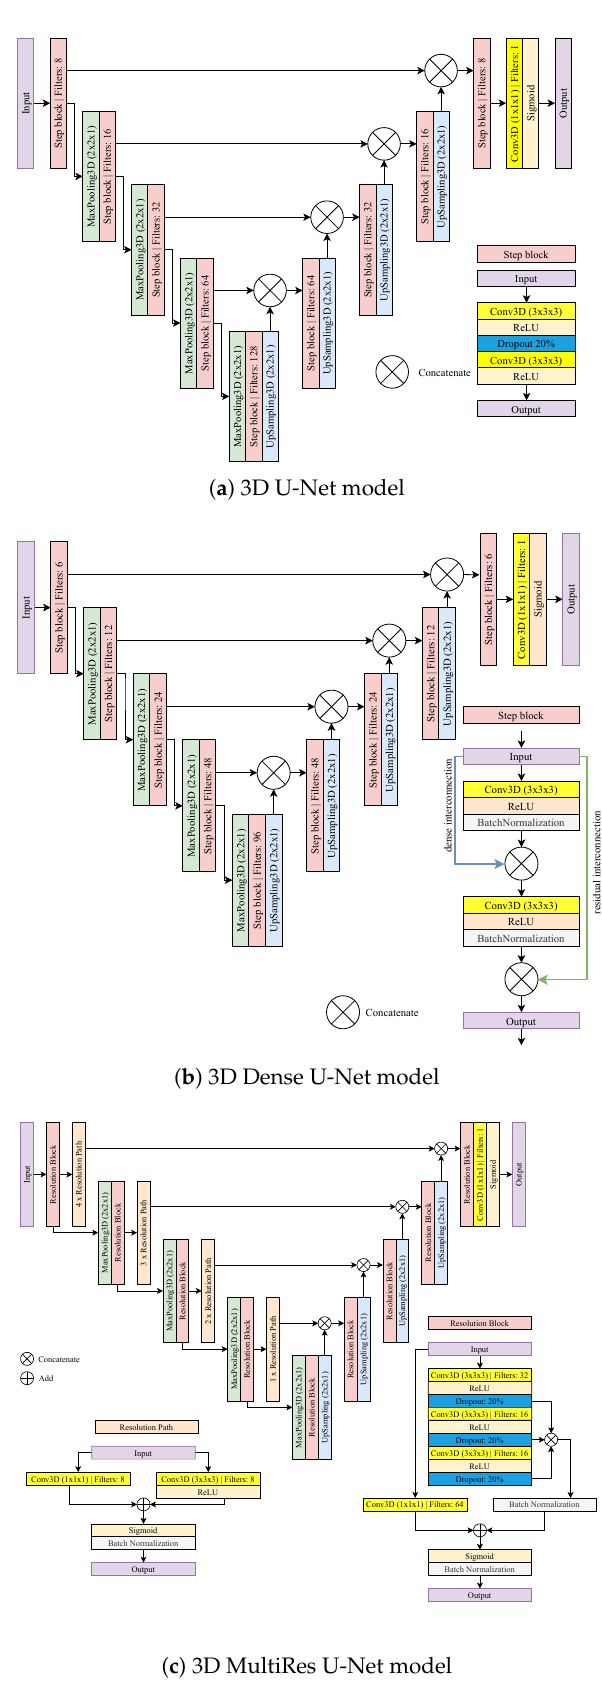
Figure 2. The U-Net-based models considered in this study for full 3D and slab-based